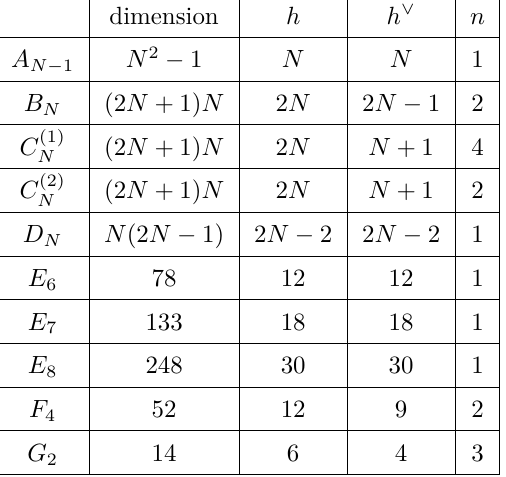
Table 4 . Lie algebra data. h is the Coxeter number and h ∨ is the dual Coexter number. n is the number which appears in the level of 2d W-algebra, see